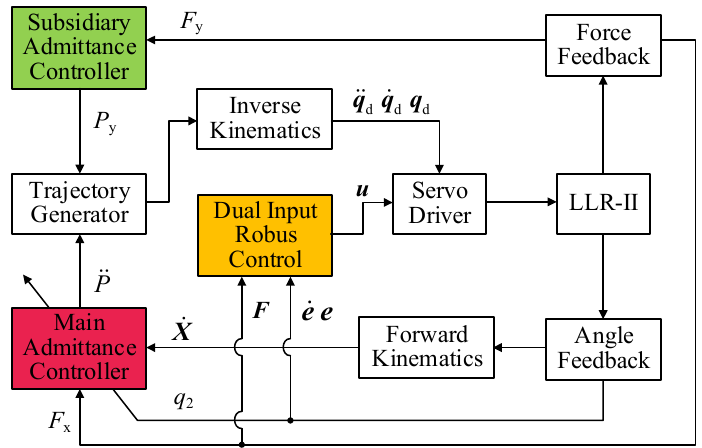
Figure 5. Admittance robust control block diagram.